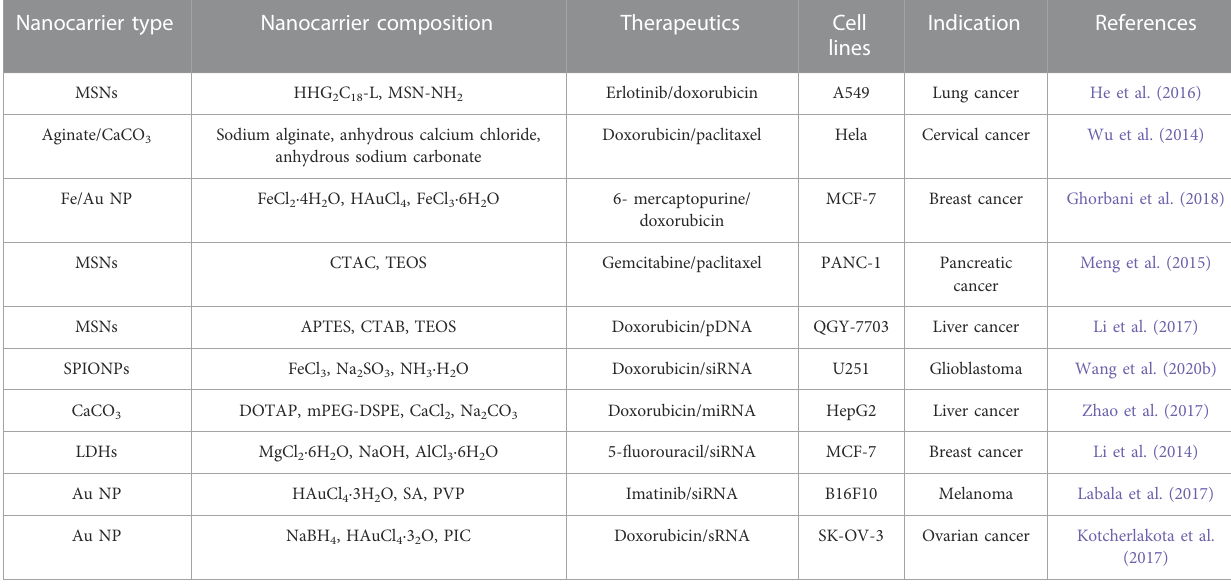
TABLE 3 Inorganic-based nanocarriers for simultaneous delivery of therapeutics for cancer